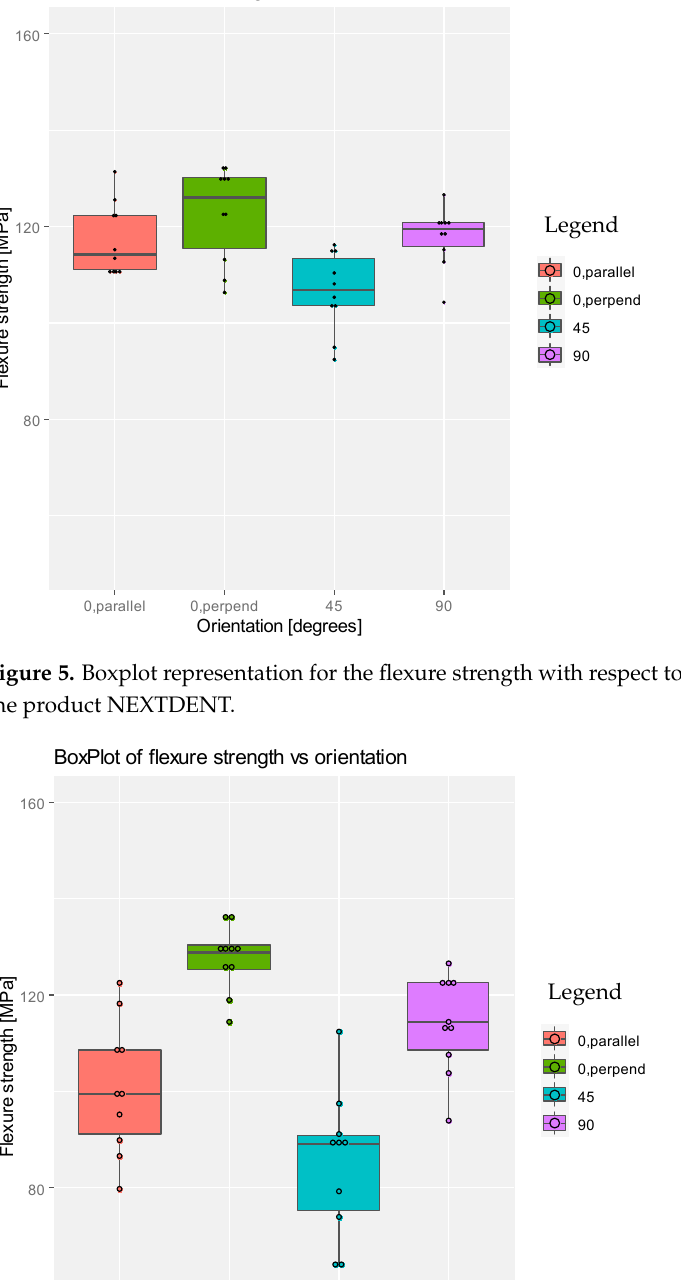
Table 3. Mean value and variance for NEXTDENT material.